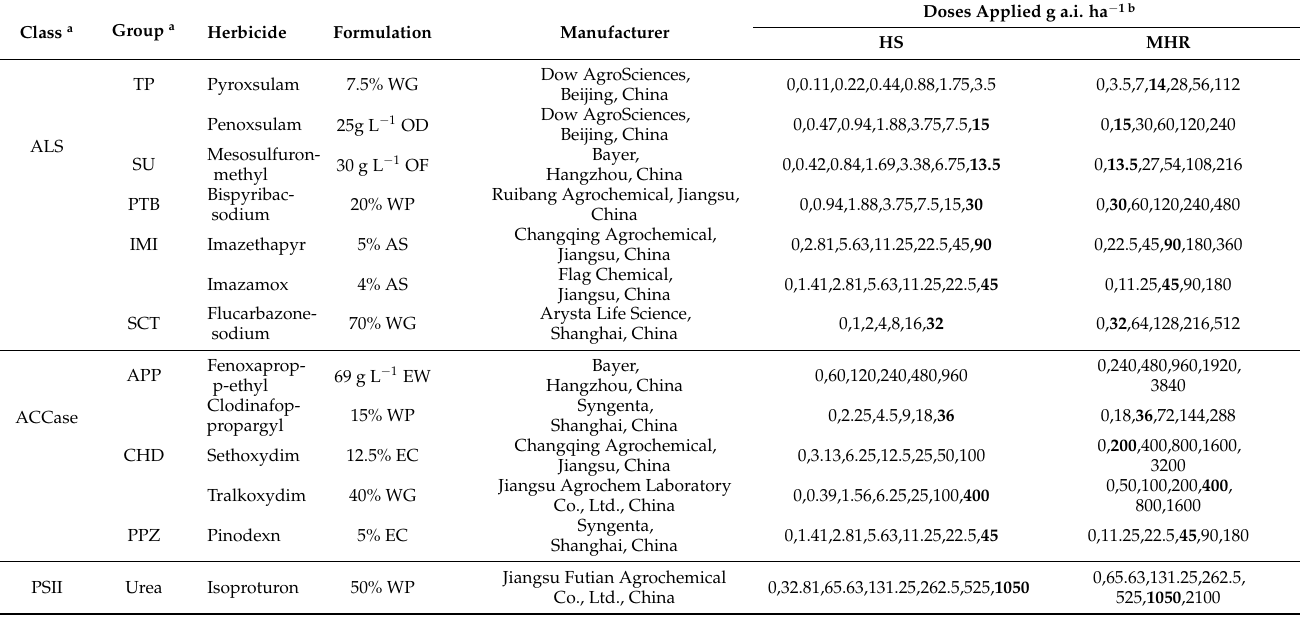
Table 2. Herbicides and their doses used in whole-plant dose–response